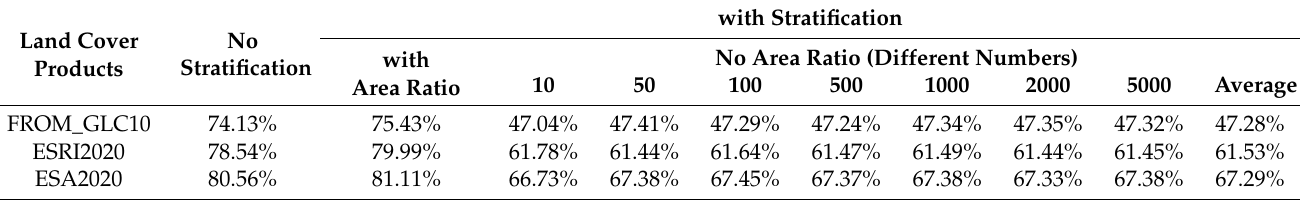
Table 9. The overall accuracy of the results assessed by the different sampling